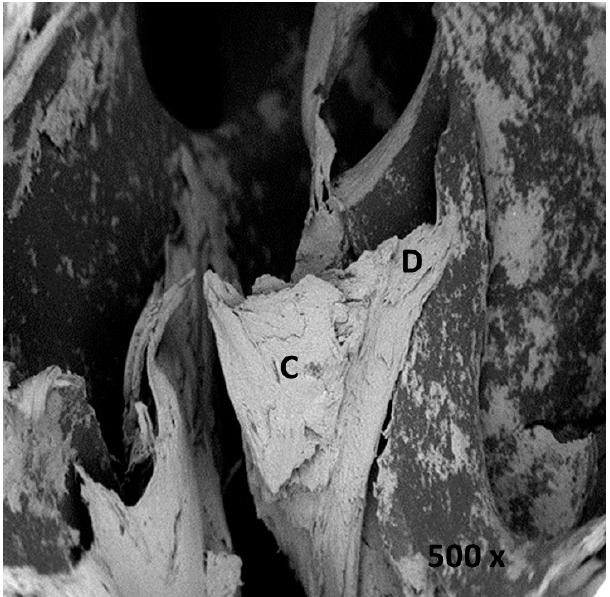
Figure 4. Piezosurgery OT12S tip sample surface (D—debris, C—carbonization).